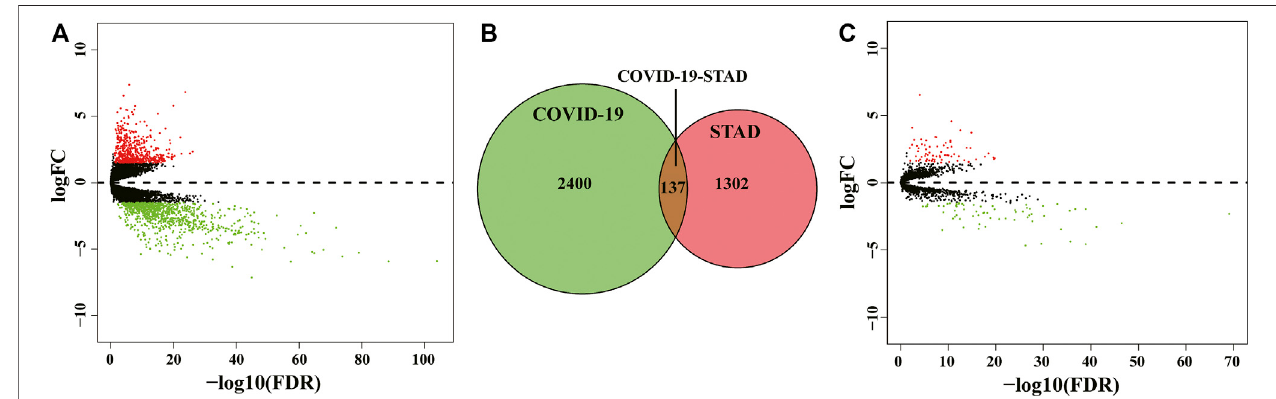
FIGURE 2 | Identi fi cation of STAD/COVID-19 target genes. (A) Volcano map of differential gene expression associated with STAD. (B) Venn diagram depicting intersecting genes in STAD/COVID-19. (C) Volcano plot of differential gene expression of STAD and COVID-19 intersecting genes.